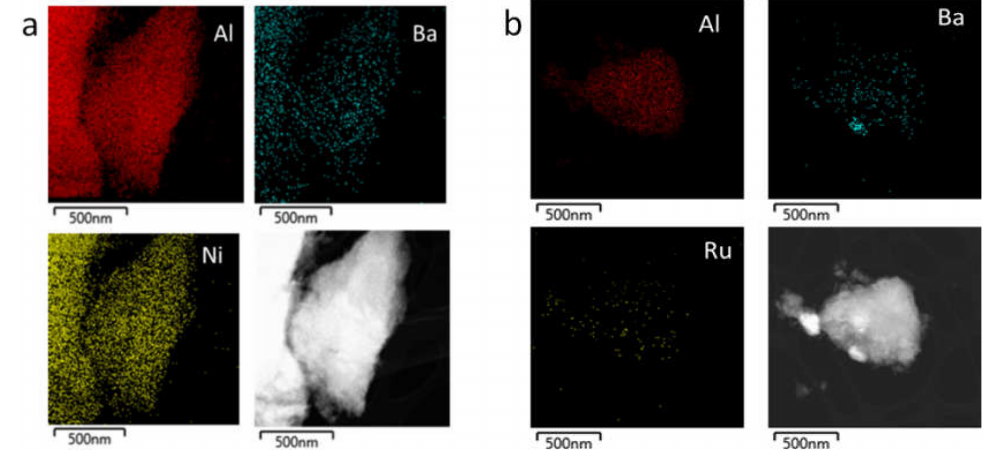
Figure 7. Representative XEDS-mapping in STEM mode for: ( a ) (10%Ba)15%Ni/Al and ( b )